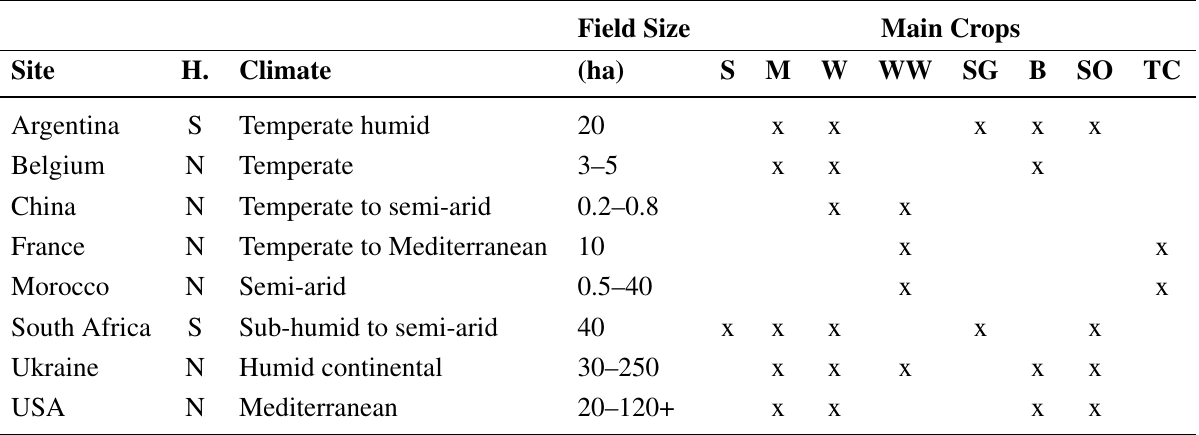
Table 1. Site descriptions. Field size: typical field size in hectares. H: hemisphere (N: northern; S: southern). Main crops: S: soya; M: maize; W: wheat; WW: winter wheat; SG: sorghum; B: barley; SO: soybean; TC: tree